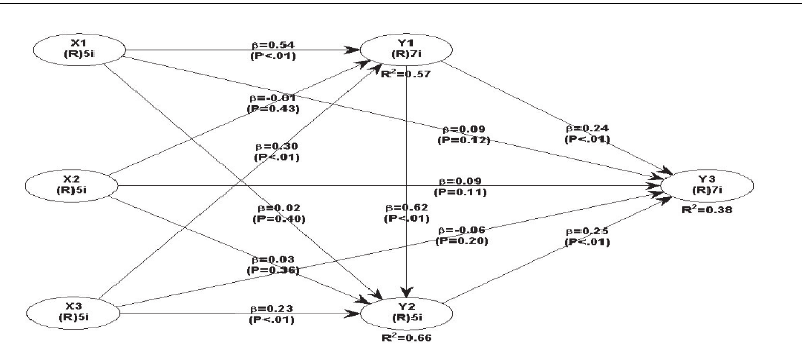
Fig. 3. Testing research